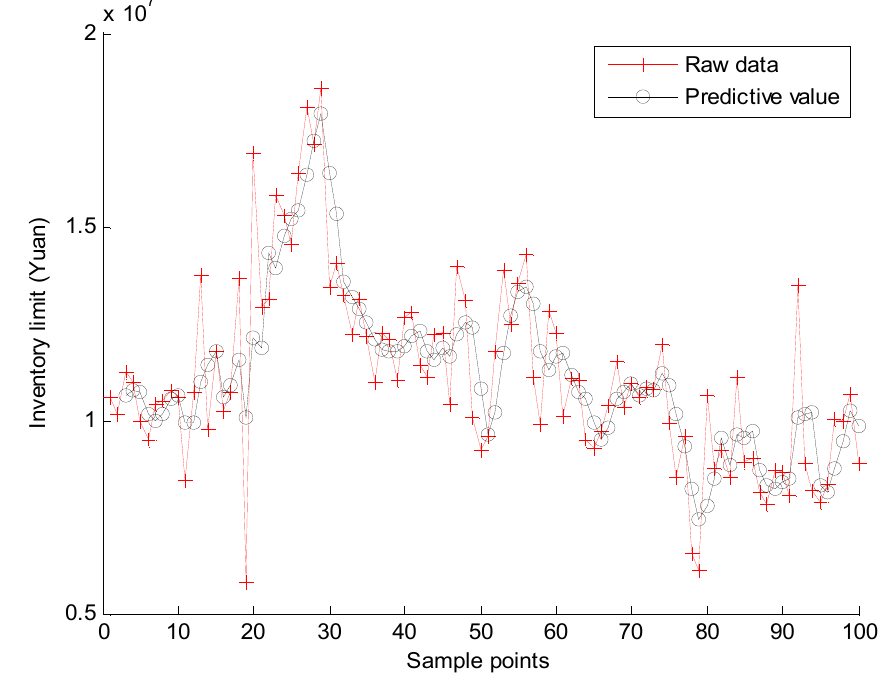
Figure 3. Predictive results of the first moving average method in